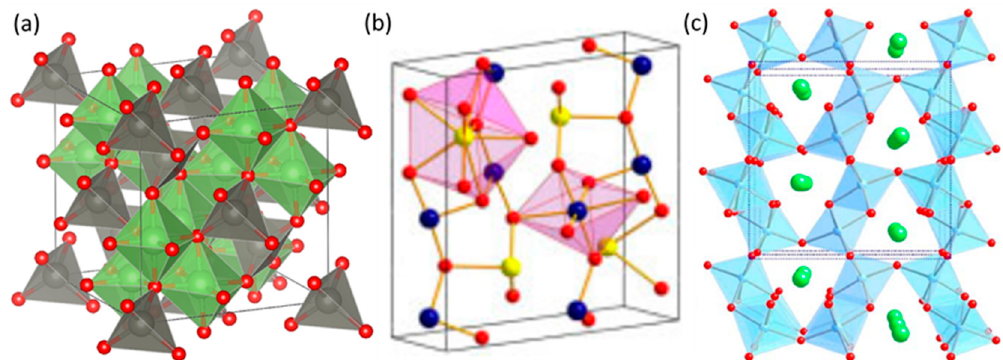
Figure 2. ( a ) Cubic spinel structure of ZnGa 2 O 4 , displaying tetrahedrally coordinated Zn atoms (in gray) and octahedrally coordinated Ga atoms (in green). Oxygen atoms are shown in red [44] (with copyright permission from American Chemical Society, 2020). ( b ) Schematic view of the orthorhombic hexagonal phase (CaMn 2 O 4 -like) of ZnGa 2 O 4 . The atom color palettes for Zn, Ga, and O are yellow, blue, and red, respectively [46] (with copyright permission from John Wiley and Sons, 2020). ( c ) The structure of CaTi 2 O 4 showing TiO 6 octahedra in blue and calcium ions as green spheres [47] (with copyright permission from Elsevier, 2020).